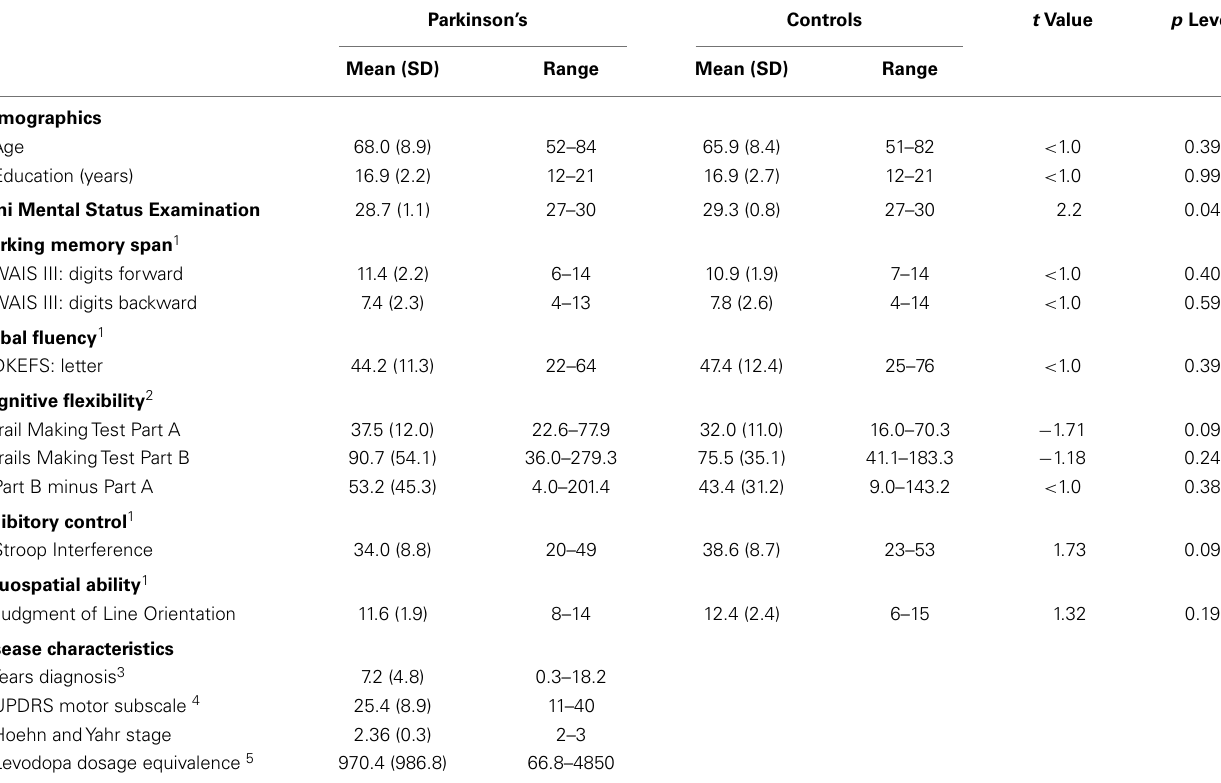
Table 1 | Characteristics of Parkinson’s and control